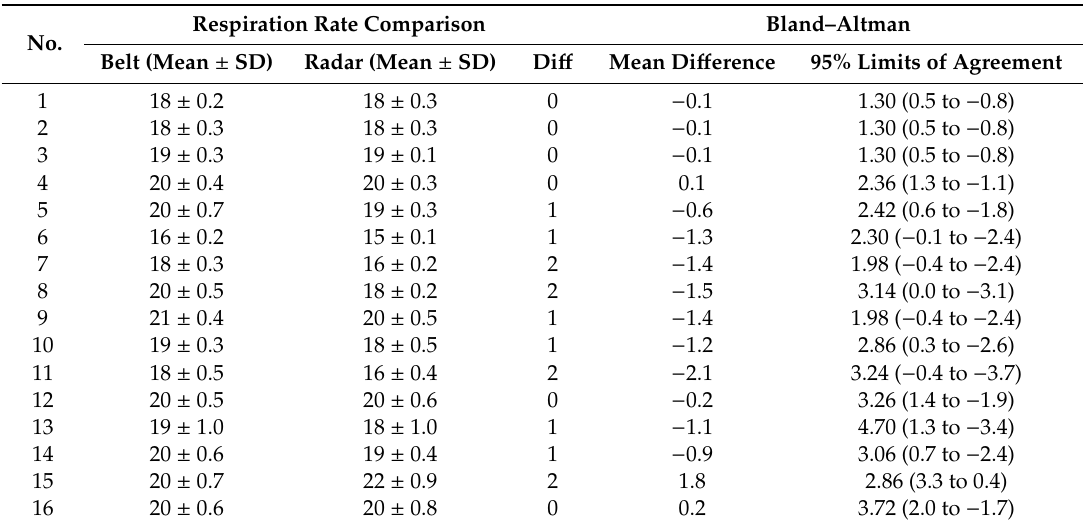
Table 1. Respiration rate result comparison between the respiration belt and radar.